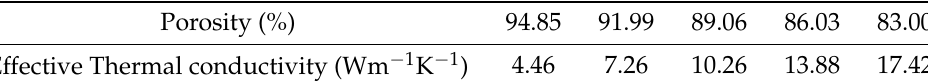
Table 6. Effective thermal conductivity of 6061 aluminum alloy GV3 structure with different porosity.